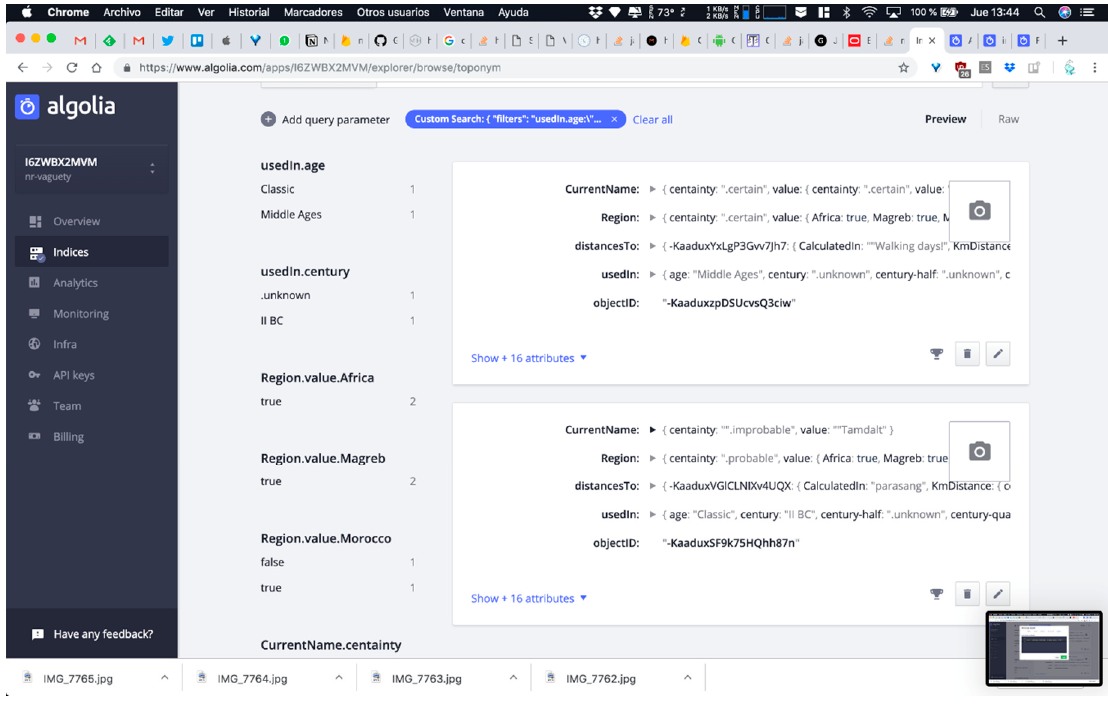
Figure 13. Results for query C .